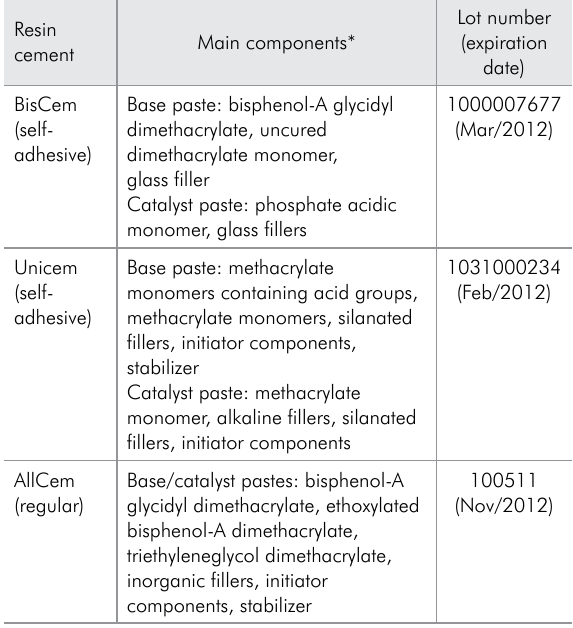
table 1. Composition of the resin cements tested. Resin